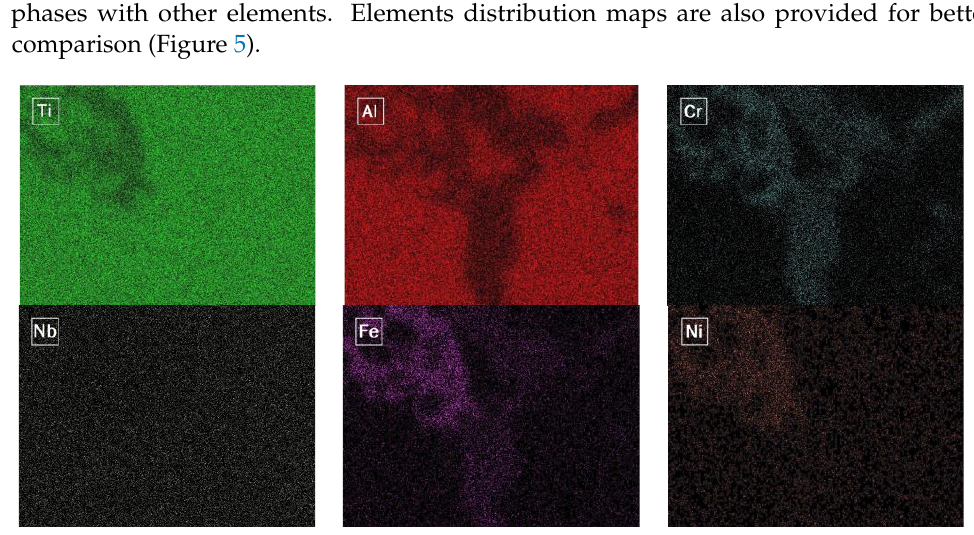
Figure 5. EDS mapping of the area in Figure 4c.